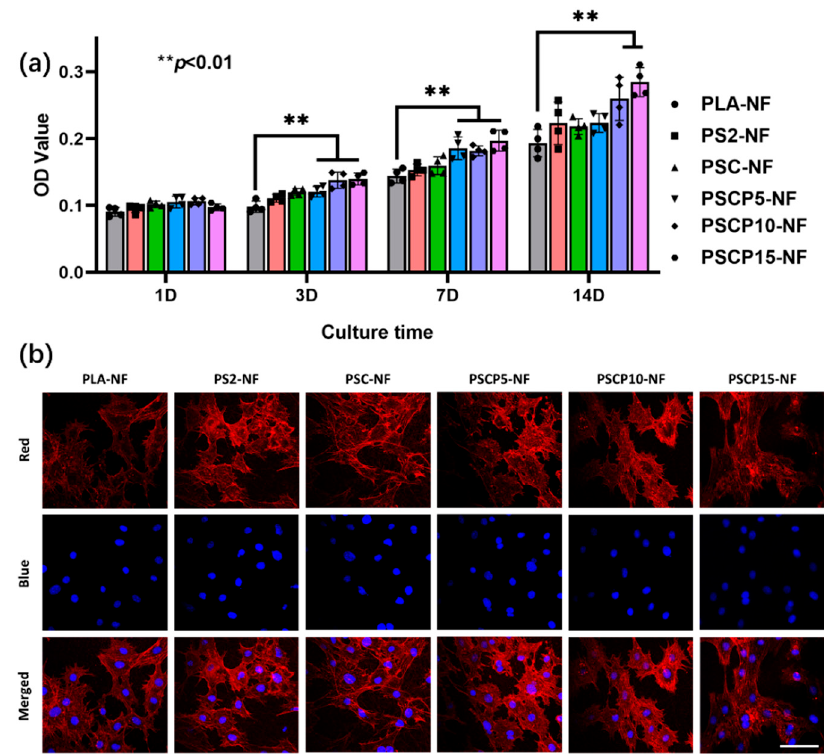
Figure 6. ( a ) MTT assay of various samples after incubation with BMSCs for different time points; ( b ) confocal laser scanning microscopy images of BMSCs seeded on various scaffolds after incubating for 3 days; the red presents the cytoplasm, and the blue presents the nucleus. Scale bar = 75 μ m.